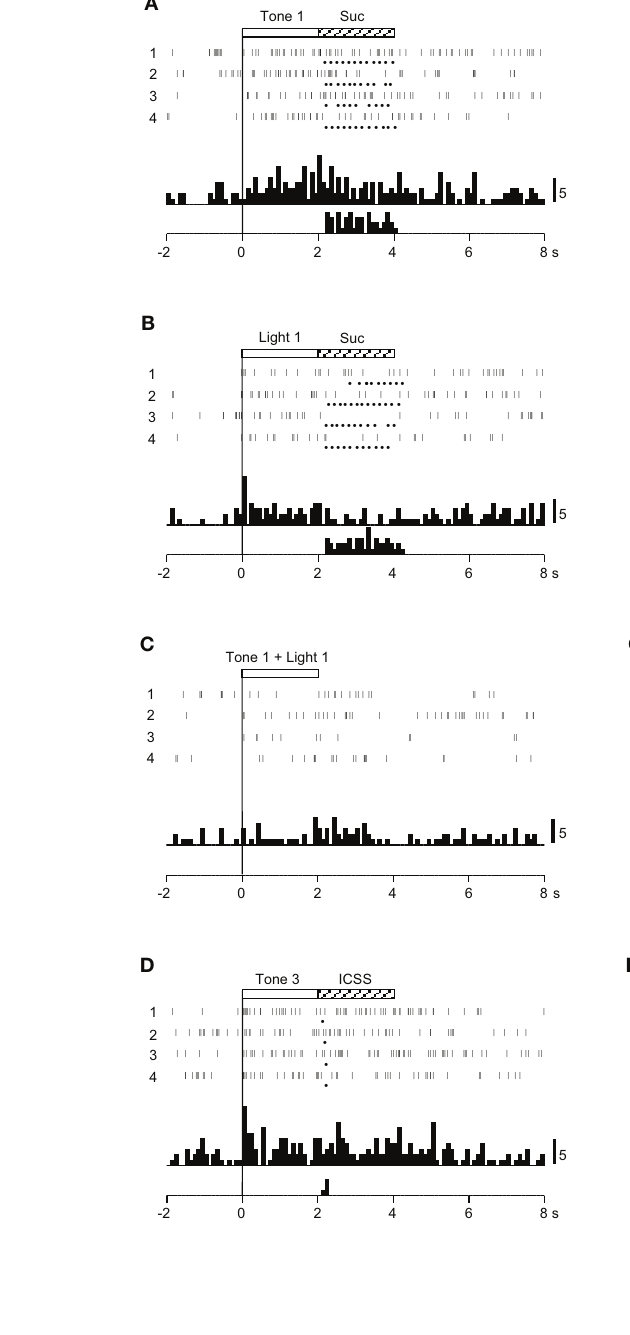
Figure 2 | Activity of a conditioned stimulus predicting reward (CS) + -related neuron that responded differently to the conditioned sensory stimuli predicting reward. (A–g) Raster displays and histograms of neuronal responses to Tone 1 predicting the sucrose solution (A) , Light 1 predicting the sucrose solution (B) , Tone 1 + Light 1 predicting non-reward (C) , Tone 3 predicting intracranial self-stimulation (ICSS) (D) , Tone 2 predicting non-reward (e) , Light 2 predicting non-reward (F) , and Tone 2 + Light 2 predicting the sucrose solution (g) . Note that neuronal activity increased during presentation of the CS + . White and hatched rectangles at the top indicate CS duration and time of reward, respectively. Each